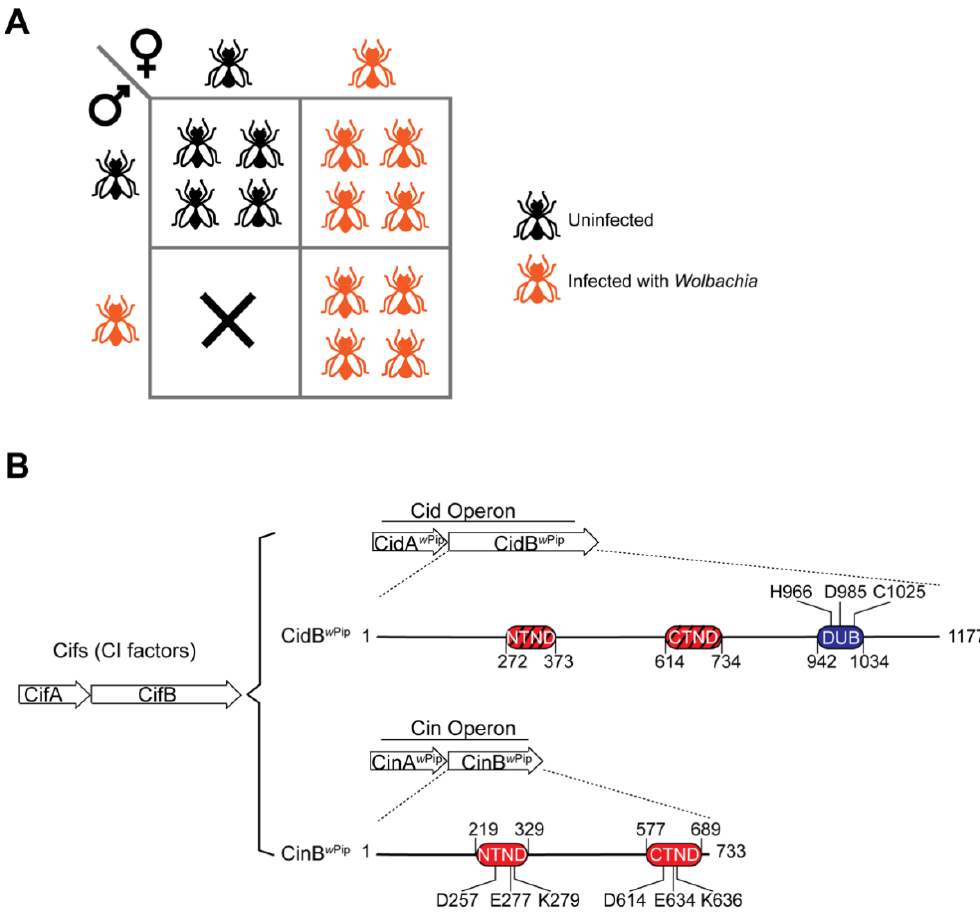
Figure 1. ( A ) Wolbachia -induced cytoplasmic incompatibility (CI). Infected females can produce viable offspring with both uninfected and infected males, while uninfected females can only produce viable offspring with uninfected males. Infections are shown in orange. Uninfected insects are shown in black. The figure illustrates so-called unidirectional incompatibility in a diploid host where only infected males mated with uninfected females cause CI, but the reciprocal cross does not. ( B ) Nomenclature of CI factors and examples of Wolbachia cid and cin operons. In this review, the term Cif is used to generally address all CI factors expressed by the reported Wolbachia two-gene operons. The upstream gene within each operon is denoted A and the downstream gene B . The cid operon encodes a deubiquitylase (DUB), CidB, whereas the cin operon encodes a nuclease, CinB. The genes in these operons are collectively termed cifs for CI factors. CifA refers to the A protein in any CI operon, including CidA and CinA, and CifB refers to the B protein in any CI operon, including CidB and CinB. Both CidB and CinB contain two predicted PD-(D/E)xK nuclease folds. However, the nuclease domains in CidB do not have all the catalytic residues needed for activity (indicated by slashes). NTND: N-terminal nuclease domain. CTND: C-terminal nuclease domain. Numbers shown represent amino acid positions, including catalytic residues within the DUB and PD-(D/E)xK domains.